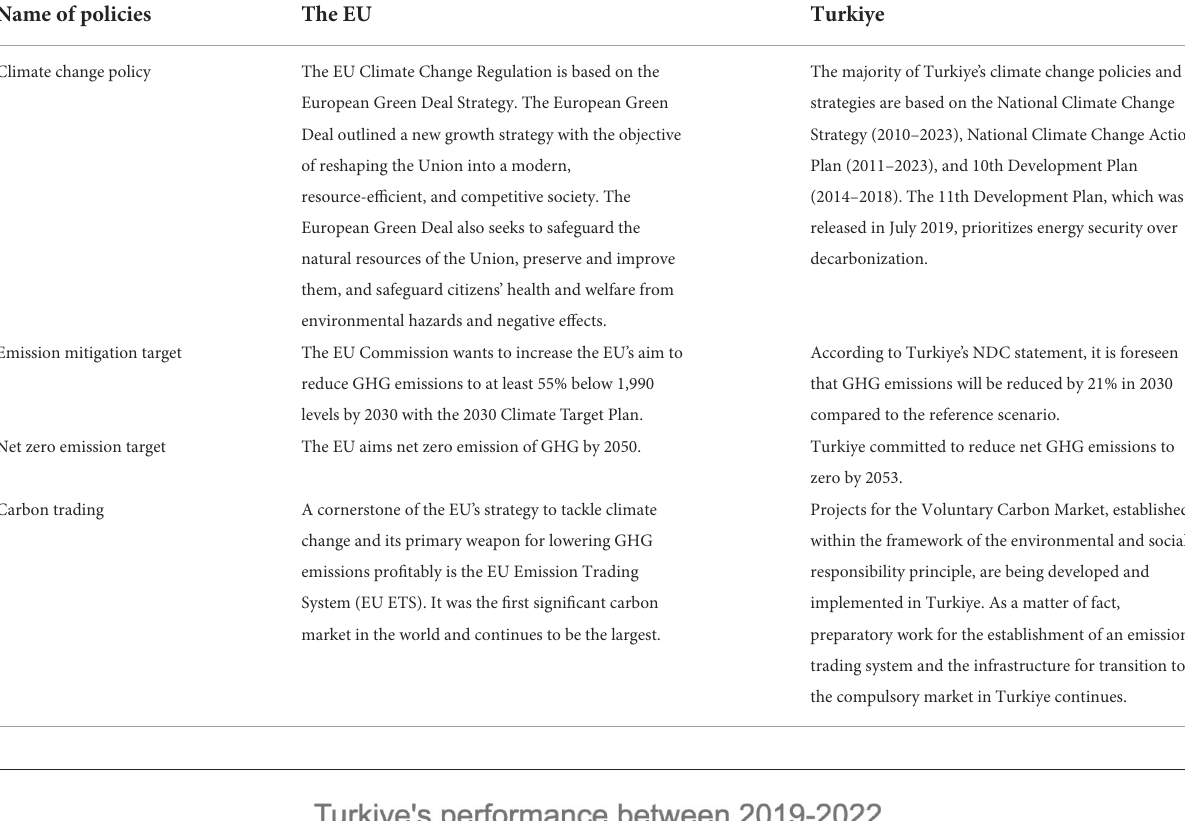
TABLE 1 Comparison of key climate change mitigation actions of Turkiye and EU.